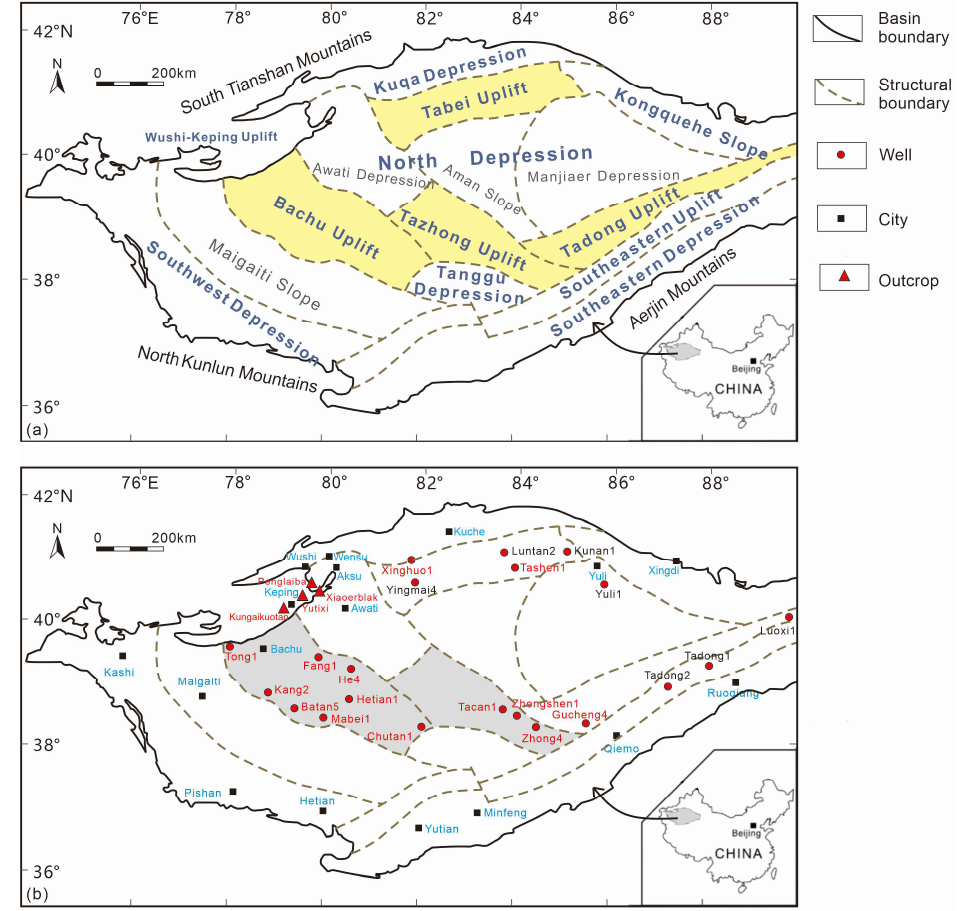
Figure 1. ( a ) Structural unit division of the Tarim Basin [35]. ( b ) Distribution of major cities, outcrops, and well drilling locations in the Tarim Basin, where the location of the study area is marked in gray and the outcrop and drilling wells with names in red font are the sample sites for this study.